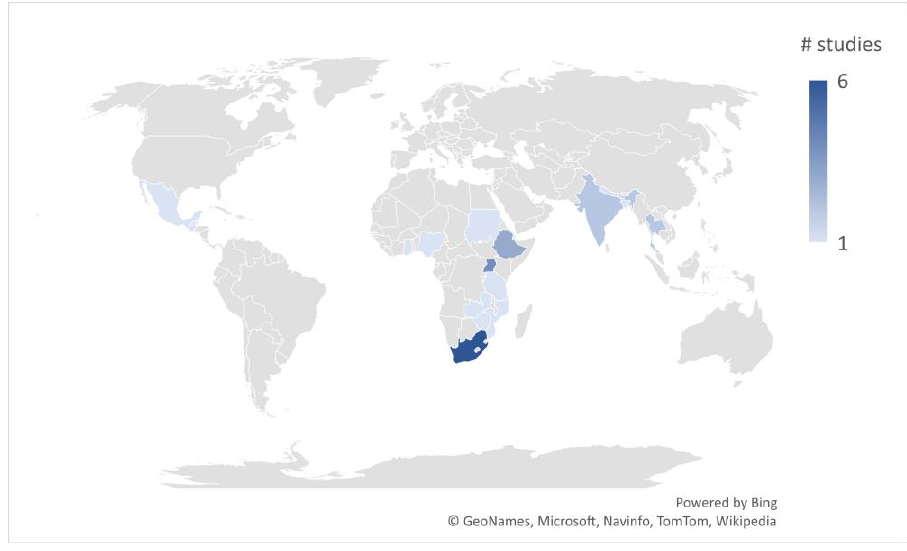
Figure 3. Heat map of primary studies.